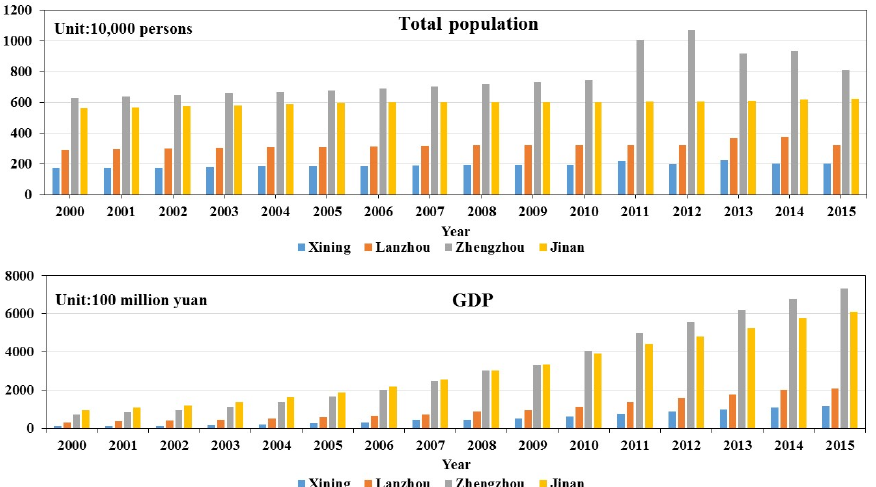
Figure 2. Statistical histogram of total population and Gross Domestic Product (GDP) in Xining,